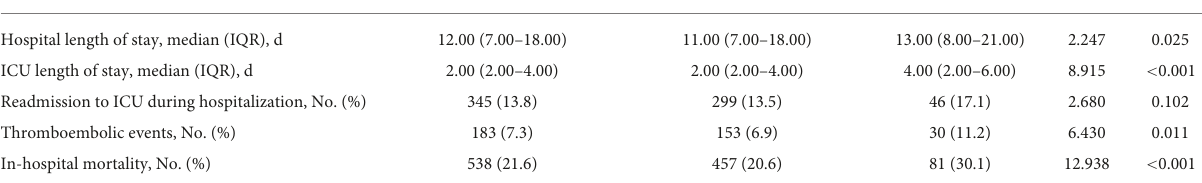
TABLE 3 Outcomes in patients with or without new-onset atrial